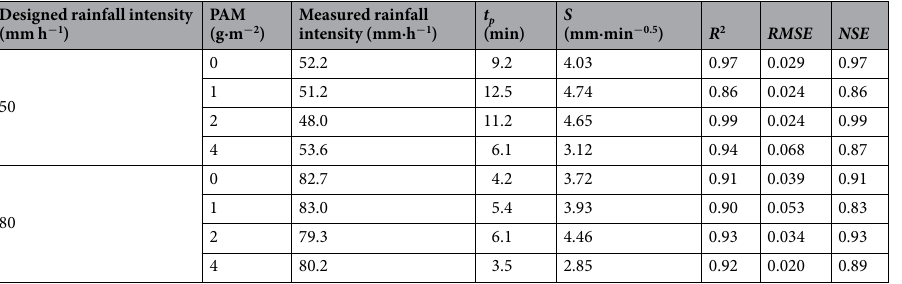
Designed rainfall intensity (mm h − 1 )